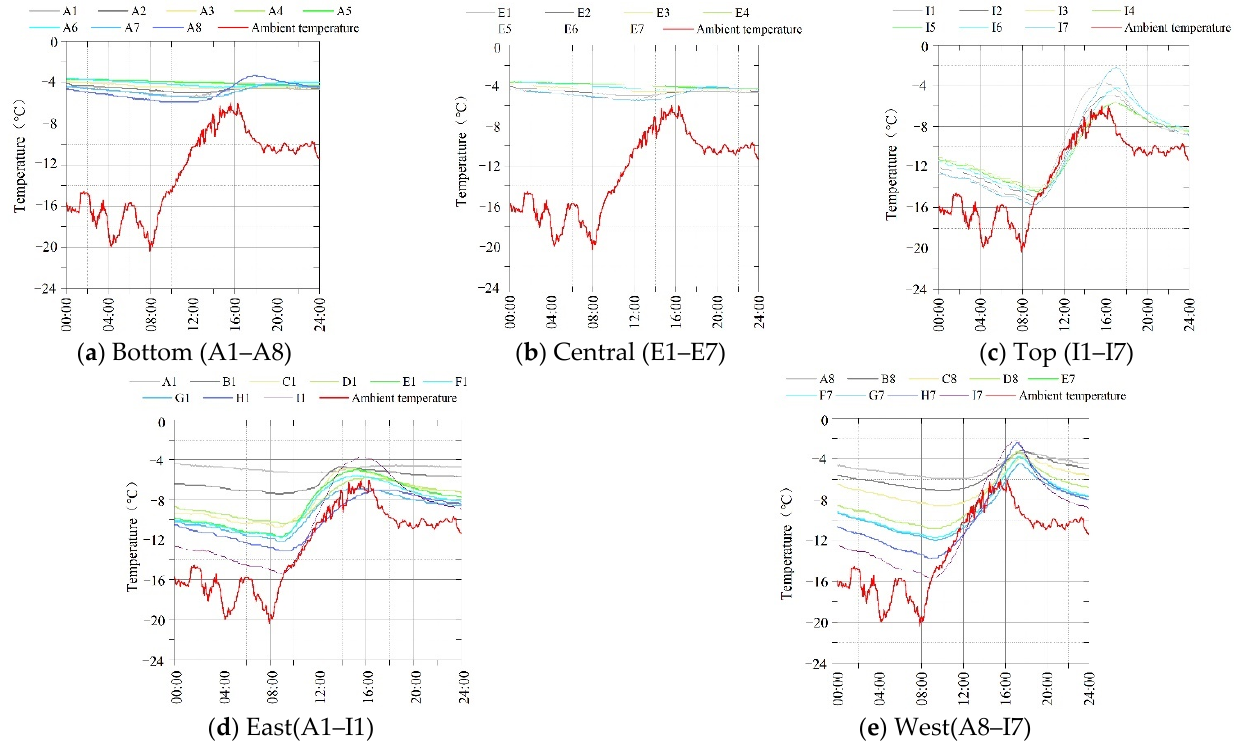
Figure 22. Variation of wall temperature during the lowest atmospheric temperature throughout the year (19 January 2018).